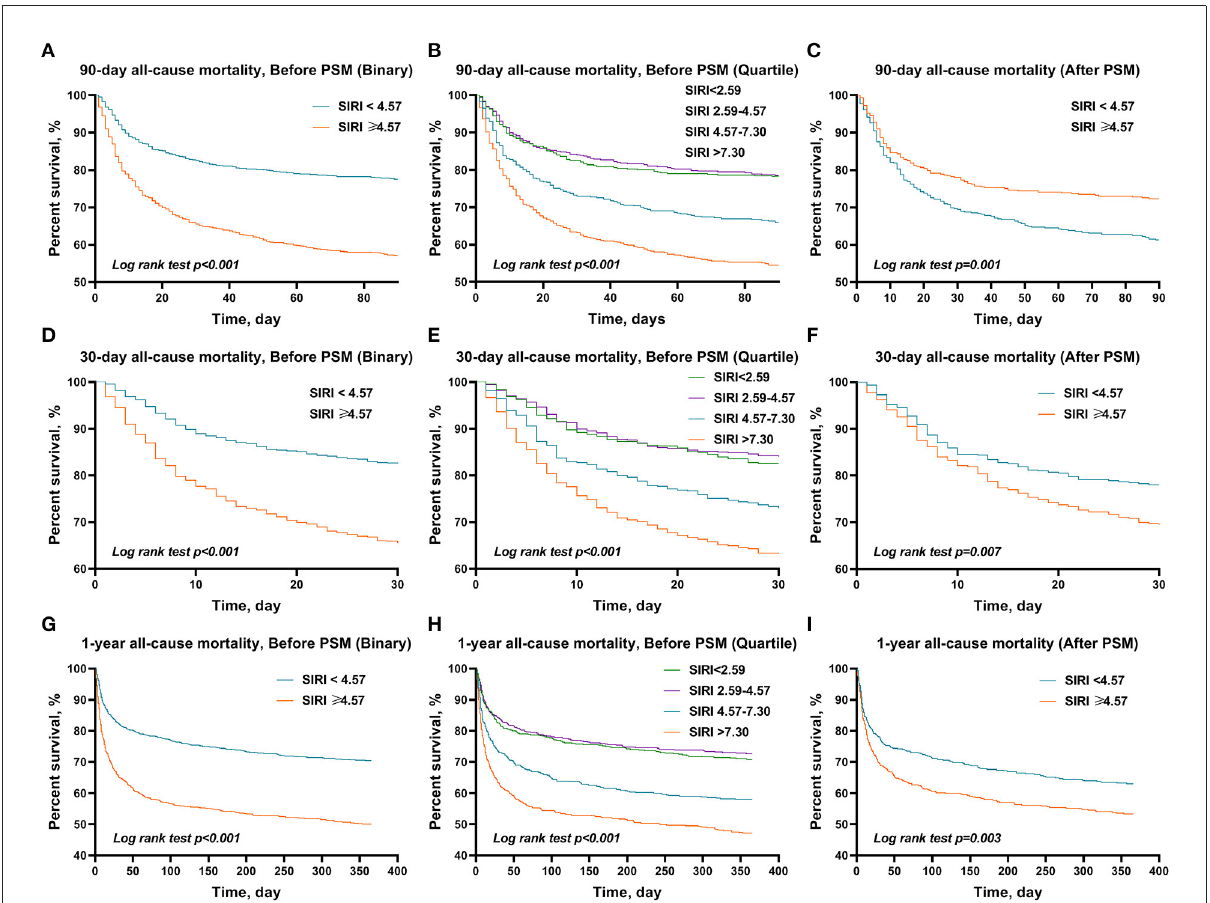
FIGURE3 The Kaplan–Meier survival plots of overall survival. A significantly lower 90-day (A) , 30-day (B) , and 1-year (C) survival rate was observed among patients in the higher SIRI ( ≥ 4.57) before PSM. It also showed significantly lower 90-day (D) , 30-day (E) , and 1-year (F) survival rates in the third and fourth SIRI quartiles compared with the first quartile in patients with AIS. After PSM, a similar trend in these outcomes was also found in 90-day (G) , 30-day (H) , and 1-year (I) overall survival. p -value was calculated by log-rank test and indicated in the plot. SIRI, systemic inflammation response index; PSM, propensity score matching.